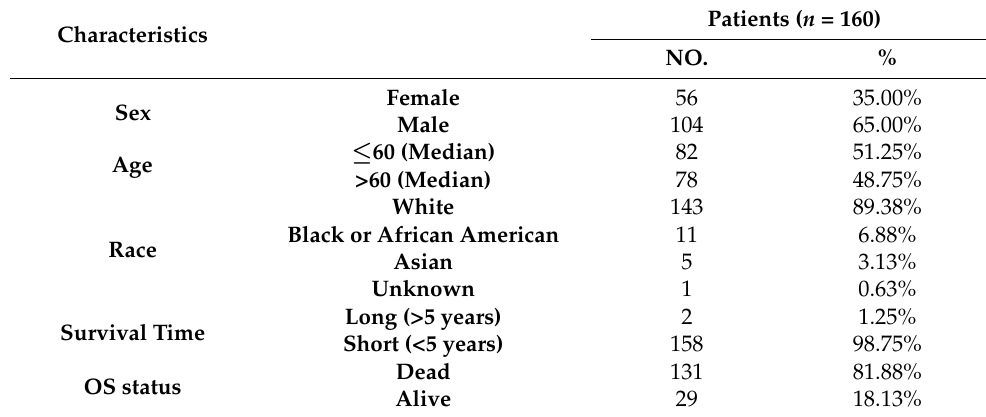
Table 1. Clinicopathological characteristics of GBM patients from TCGA database.